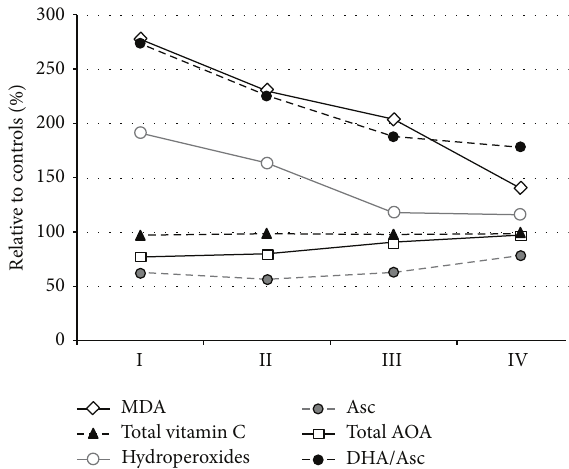
Figure 1: The time-course of serum hydroperoxides and MDA, total AOA, total vitamin C, Asc, and oxidized/reduced vitamin C ratio (DHA/Asc)inacutebacterialOM,assessedonadmission(I),on2nd week (II), on 3rd week (III) and at the end of hospital stay (IV). The results are expressed relatively to control